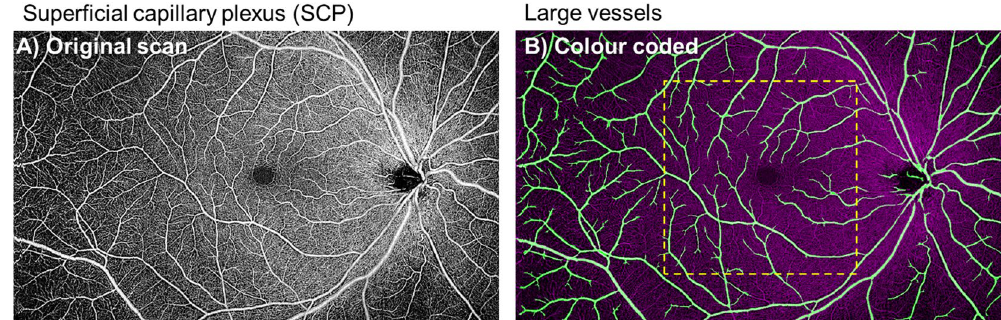
Figure 1. The superficial capillary plexus image ( A ) was processed to obtain the large vessel metrics ( B ; colored coded in green). Perfusion densities were investigated in 2 different regions of the large vessels: (1) the macular region (within yellow dotted box) with a 6 × 6-mm 2 region centred over the fovea and (2) the peripheral region (outside the yellow dotted box). Image A was generated from the built-in review software (PLEX Elite Review Software, Carl Zeiss Meditec, Inc., Dublin, USA; Version 1.7.1.31492; https ://www.zeiss .fr/conte nt/dam/Medit